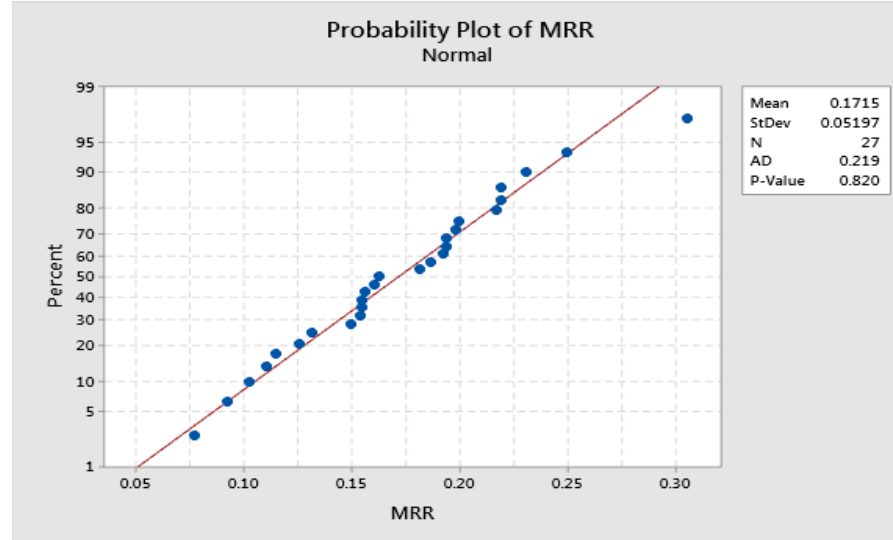
Figure 6. Normal probability plot of residuals for MRR.